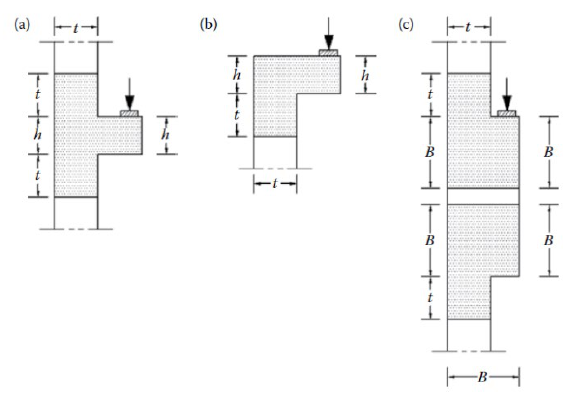
Figure 2. Discontinuity regions in